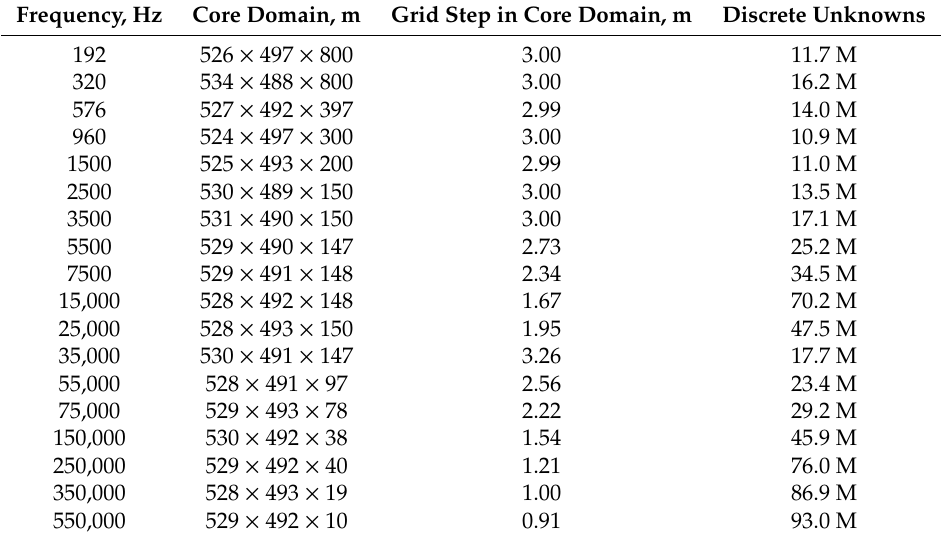
Table 5. Computational grids at di ff erent frequencies.